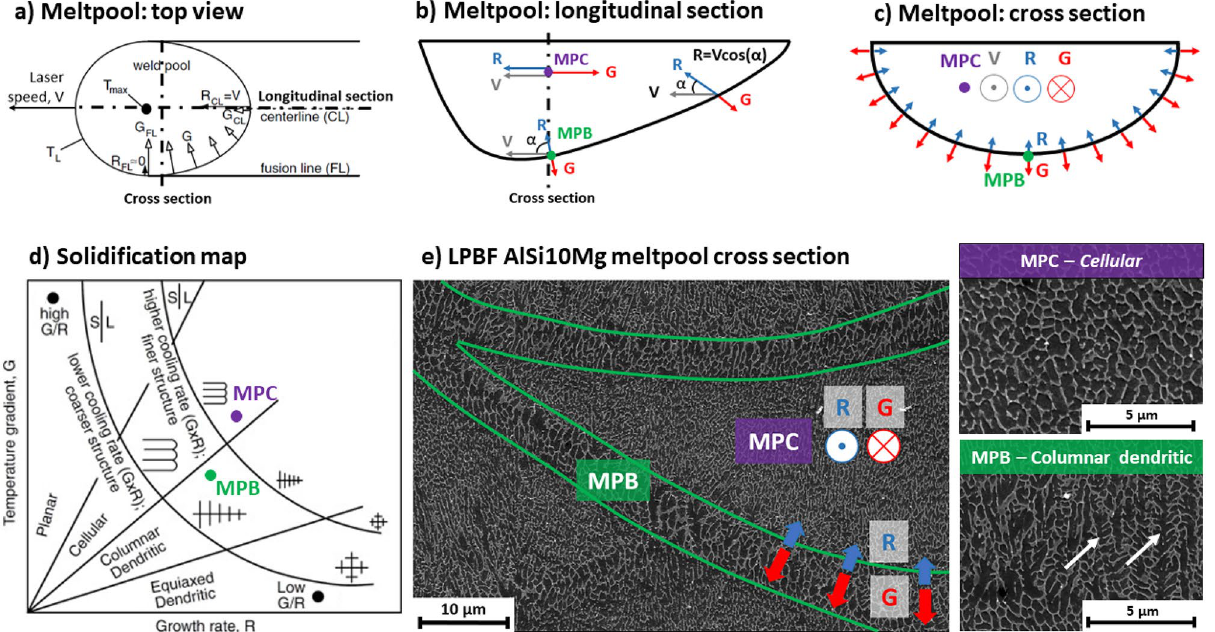
Figure 6. Metlpool schematics indicating local principal thermal gradient vectors (G) and interface growth rate vectors (R) within the meltpool, affecting the solidification modes in the meltpool centre (MPC) and meltpool boundary (MPB). ( a ) meltpool top view; ( b ) meltpool longitudinal section; ( c ) meltpool cross-section; ( d ) solidification map; ( e ) SEM image of LPBF AlSi10Mg (AB) showing the microstructure within the meltpool with a cellular morphology at the MPC and columnar dendritic morphology at the MPB. ( a ) and ( d ) adopted from Kou 20